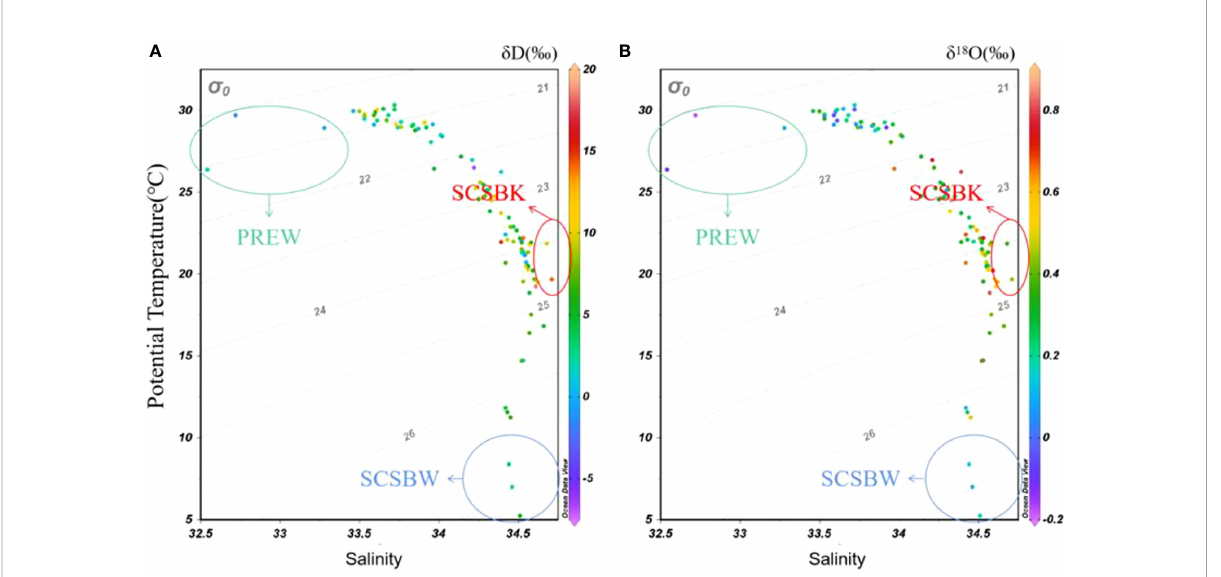
FIGURE 5 Plots of potential temperature (°C) versus salinity for water column of the Pearl River Estuary. Colors indicate (A) d D and (B) d 18 O values. Three water masses, PREW, SCSKB, and SCSDW, were also marked with ellipses. PREW, Pearl River fl ushing water; SCSKB, South China Sea Kuroshio Branch; SCSBW, South China Sea bottom water.